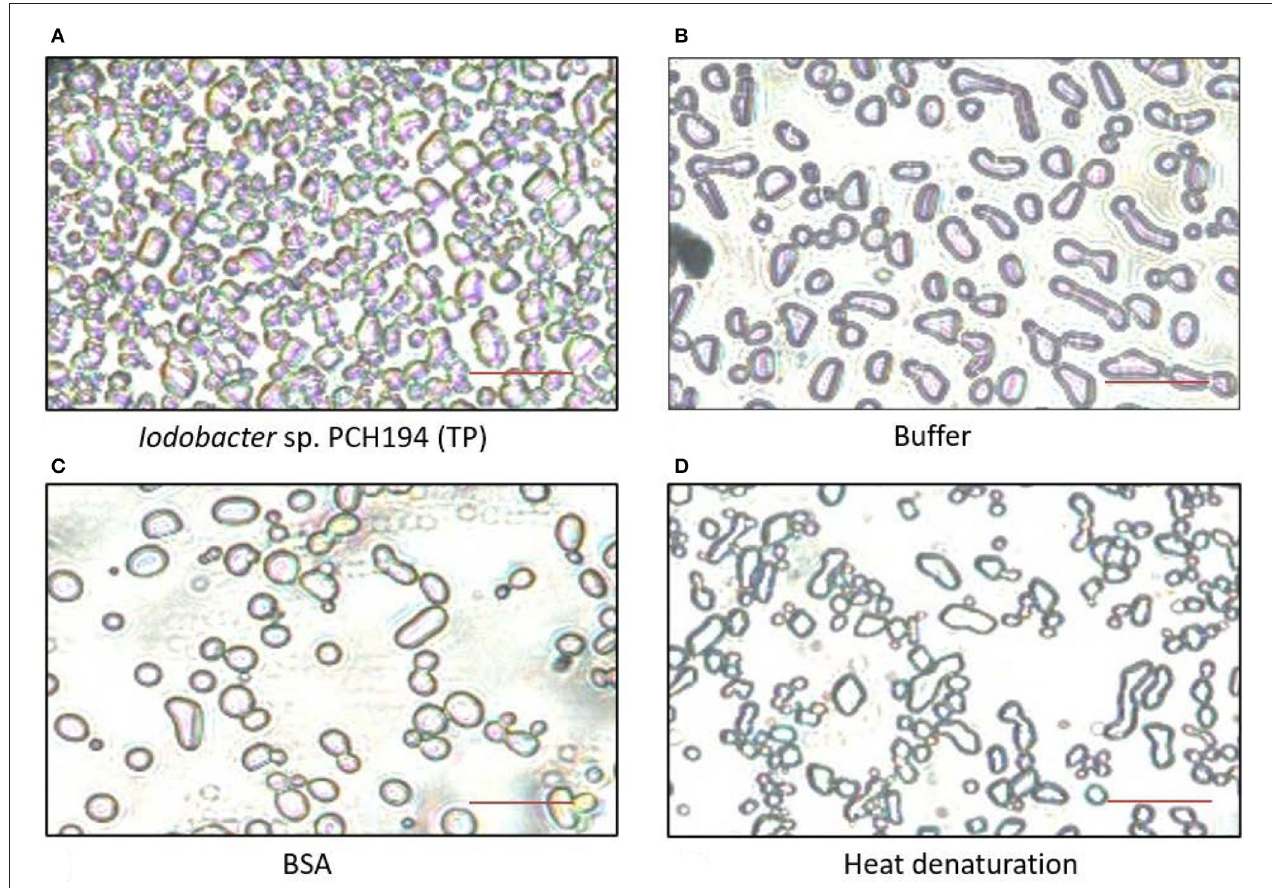
FIGURE 3 | Antifreeze activity exhibited by Iodobacter sp. PCH194. The ice recrystallization inhibition (IRI) was observed at − 9 ◦ C after 40min. (A) Iodobacter sp. PCH194 [total cell lysate protein (TP), 1.0 mg/ml] showed smaller ice crystals upon recrystallization in comparison to (B) buffer (20mM Tris-HCl, pH 8.0), and (C) BSA (1.0 mg/ml) as a negative control, and (D) heat denaturation (at 100 ◦ C for 10min) of Iodobacter sp. PCH194 (TP) resulted in the loss of activity. Scale bar = 200 µ